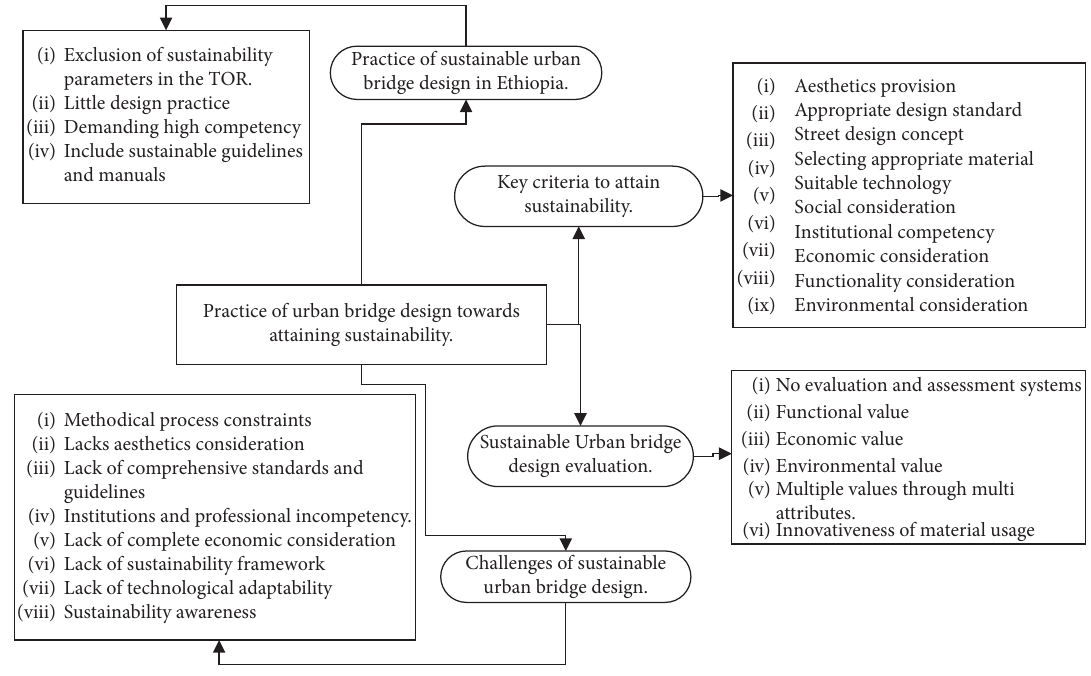
Figure 2: Te state of sustainable urban bridge design in Ethiopia.